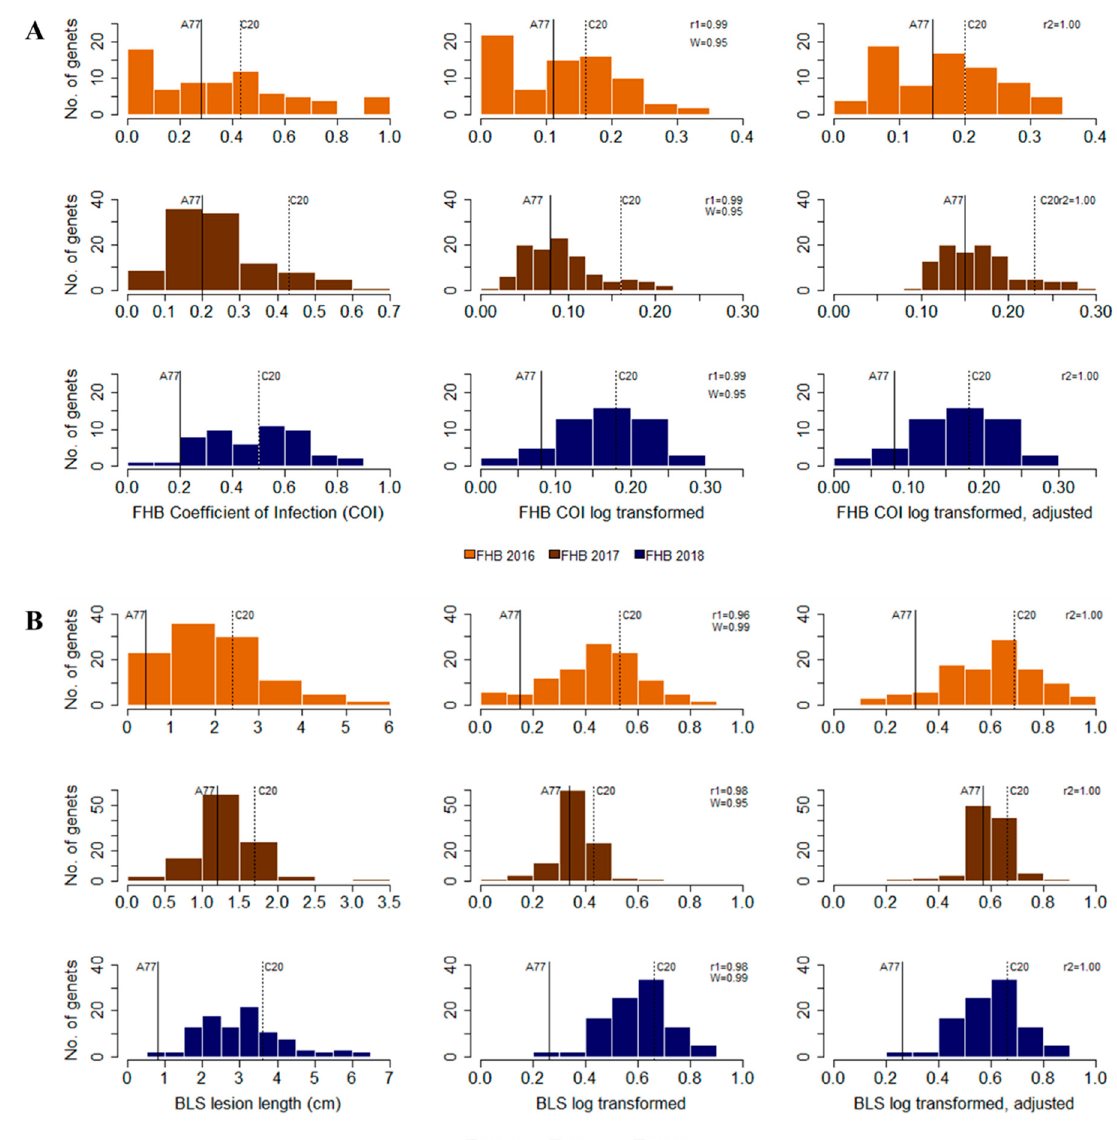
Figure 2. Distribution of phenotypic data observed in the A77-3 × C20-7 IWG F 1 mapping population and their log-transformations: ( A ) Fusarium head blight (FHB), and ( B ) bacterial leaf streak (BLS) in 2016, 2017, and 2018. “r1” is the Pearson’s correlation value between the disease phenotypic data and log-transformed data, and “r2” is the correlation between log-transformed data and data adjusted in SAS for trial differences. The Shapiro-Wilk test statistic between the phenotypic data and log- transformed data is indicated by “W”. Data points of the parents A77-3 and C20-7 are shown with a solid line and dashed line, respectively.